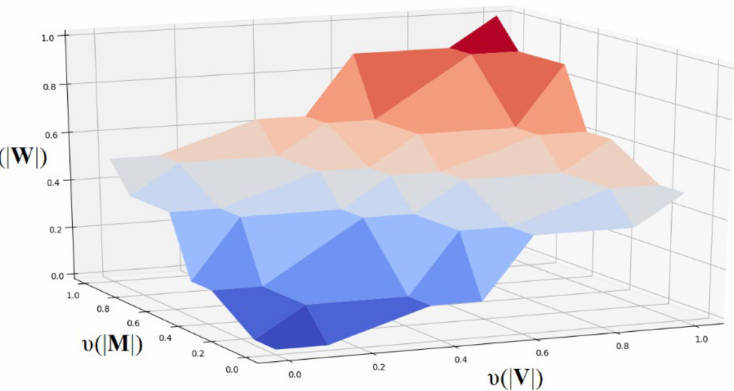
Figure 2. The realgridsurface describes the semantic relationship between | W |, | M | and | V | based on the four-point bilinear interpolation method.